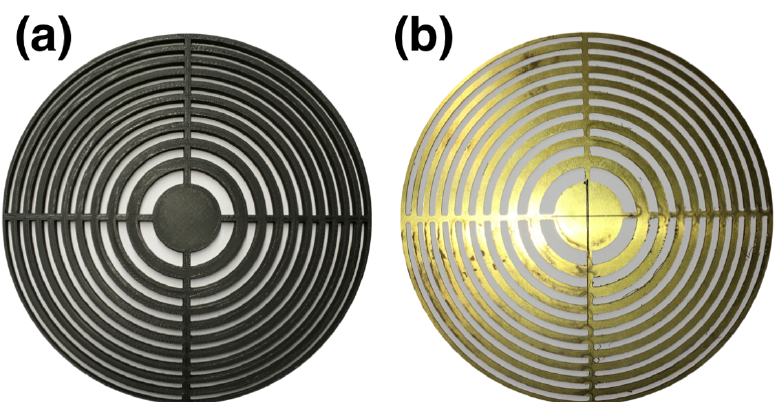
Figure 4. Implemented lenses, ( a ) PLA and ( b )